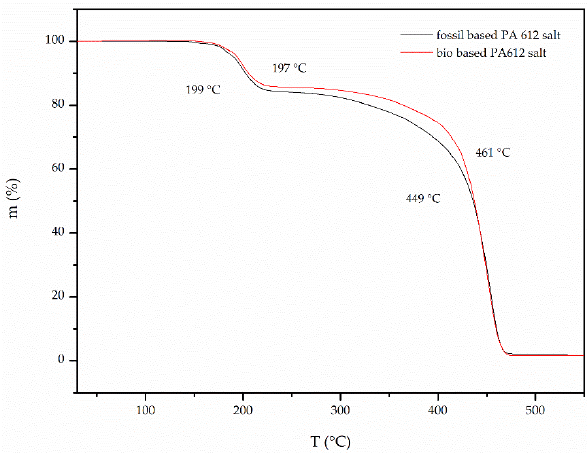
Figure 3. TGA graphs of fossil- and bio-based PA 612